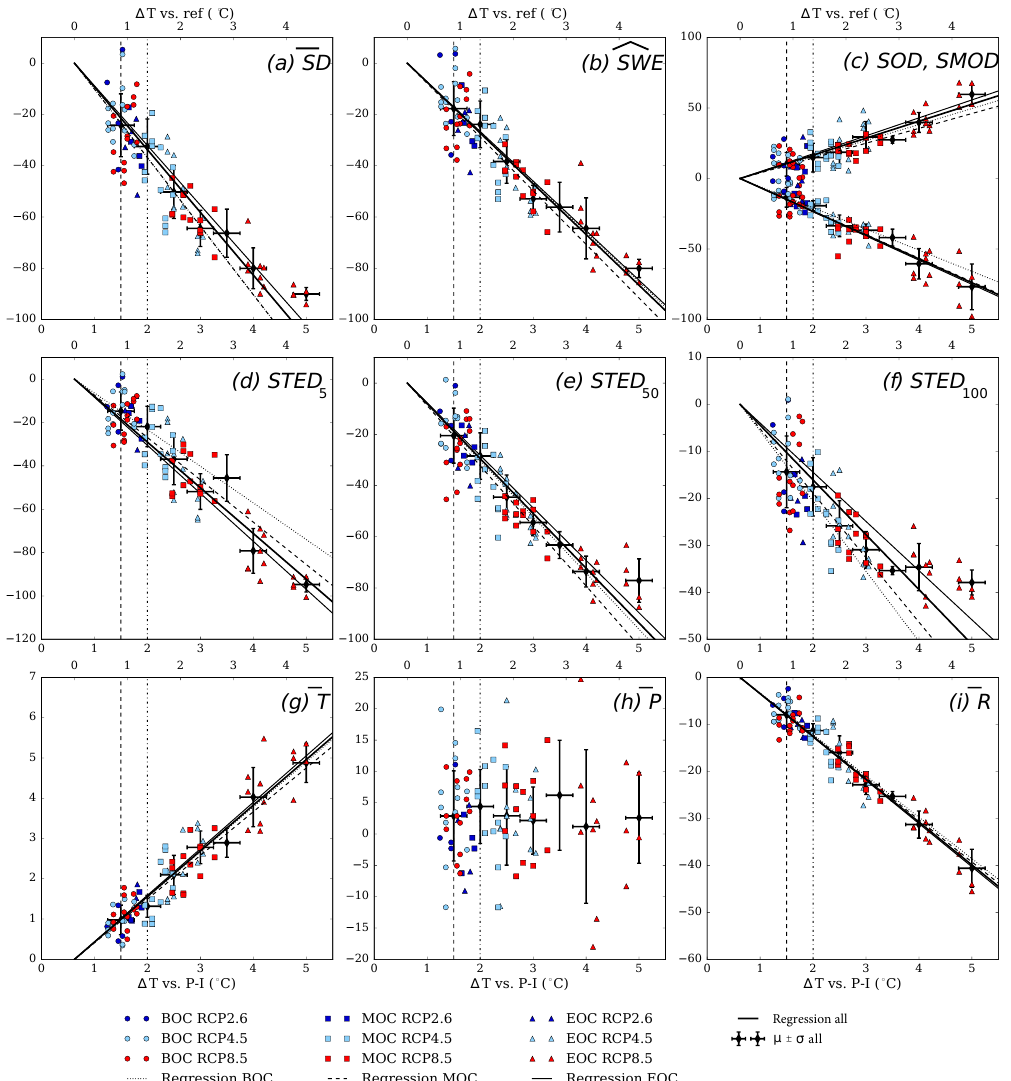
Figure 6. Response of local meteorological and snow indicators to global warming level. Indicator response is computed as the difference of multi-annual means between end of century (EOC, 2071–2100), middle of century (MOC, 2041–2070), or beginning of century (BOC, 2011– 2040) and the reference period (Ref, 1986–2005). Global warming level is computed as the difference in global mean surface air temperature between EOC, MOC or BOC and either the reference period (top axes) or the preindustrial period (P-I, 1851–1880) (lower axes). Each point corresponds to a snow or meteorological indicator computed using a given RCP and one GCM–RCM pair, for which the global surface air temperature change is inferred from the corresponding GCM run: (a) SD (%), (b) (cid:91) SWE (%), (c) SOD and SMOD (days), (d) STED 5 (days), (e) STED 50 (days), (f) STED 100 (days), (g) T ( ◦ C), (h) P (%), and (i) R (%). Warming levels of 1.5 and 2 ◦ C compared to preindustrial are shown with the vertical dashed lines. Regression lines are shown for the response at EOC, MOC, BOC or all three periods (ALL) (except for P ). Mean values and standard deviations among ALL changes in each indicator for 0.5 ◦ C (cid:49)T g , EOC − PI intervals ( ± 0.25 ◦ C) are displayed as error